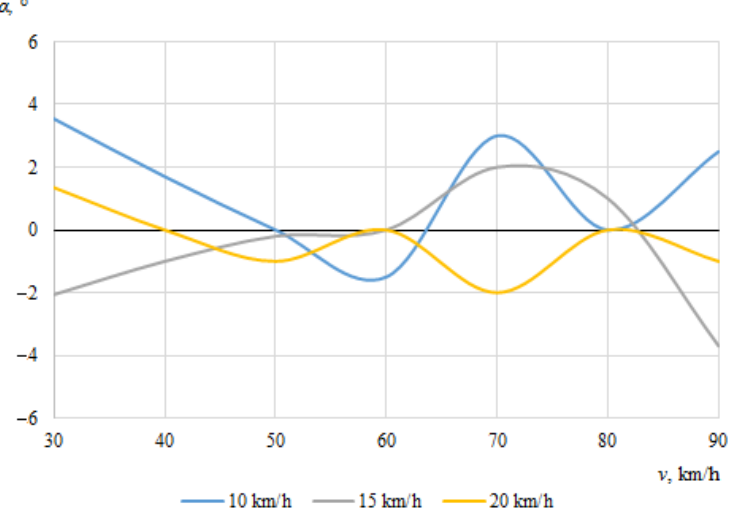
Figure 9. Cyclist throwing angle (impact angle 0°).